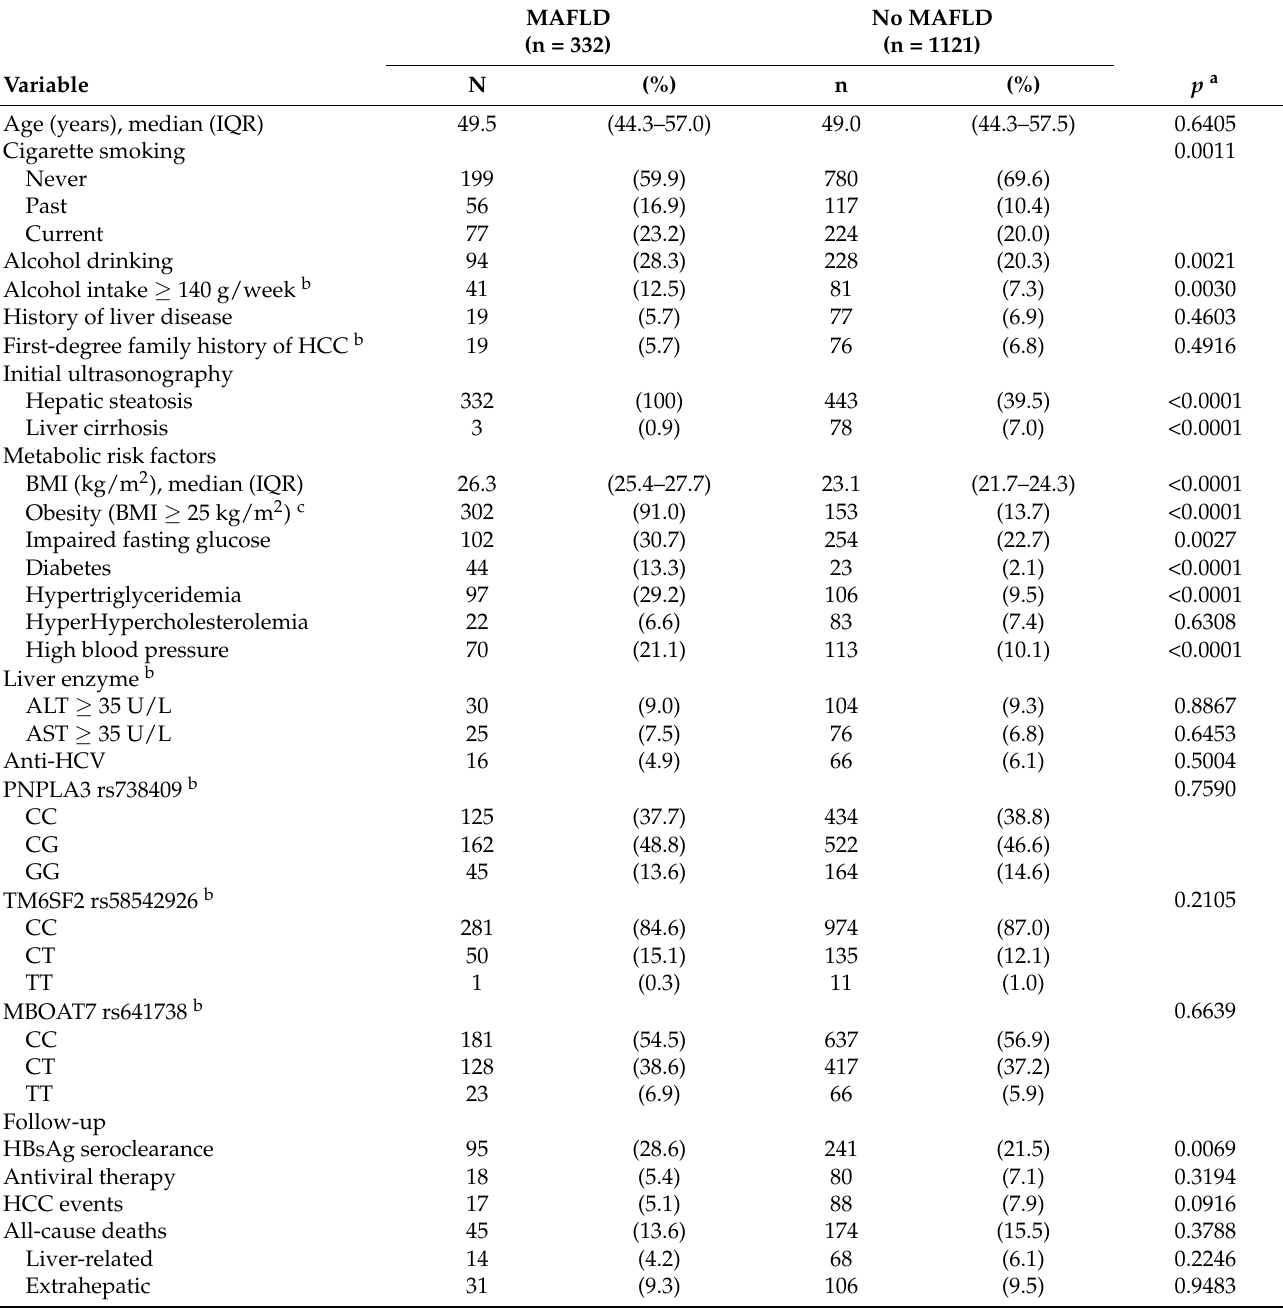
Table 1. Baseline characteristics of subjects by MAFLD